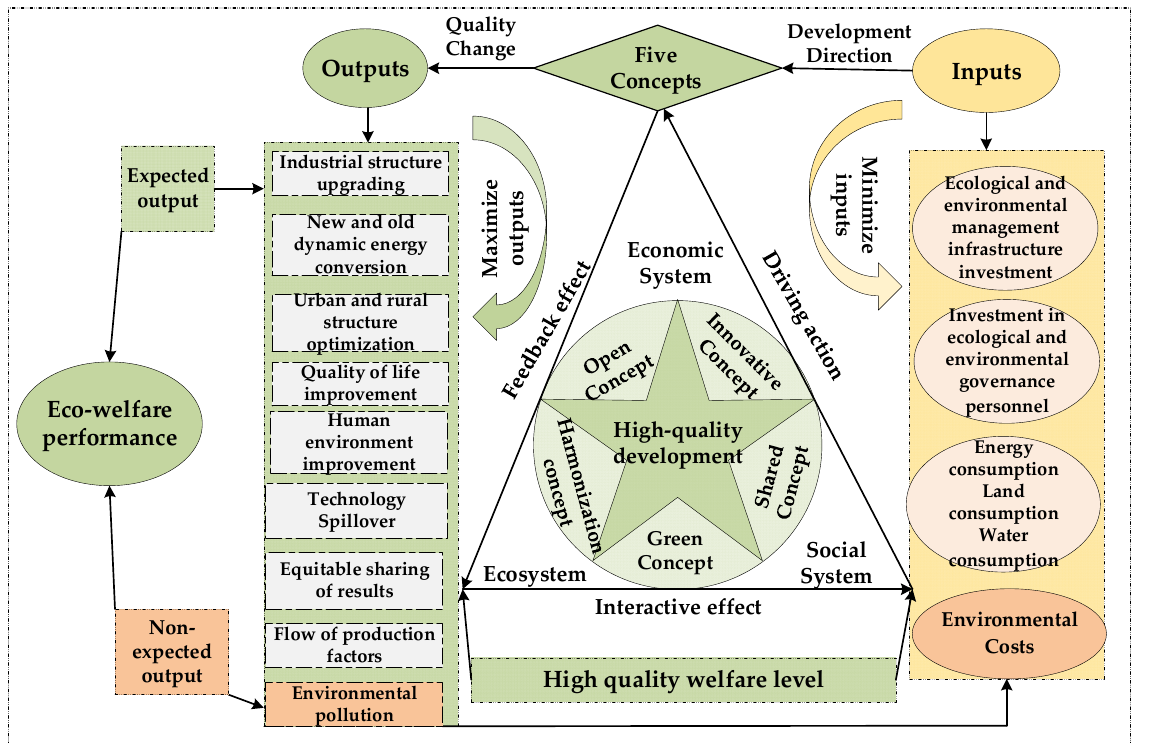
Figure 2. Theoretical framework of urban eco-welfare performance.